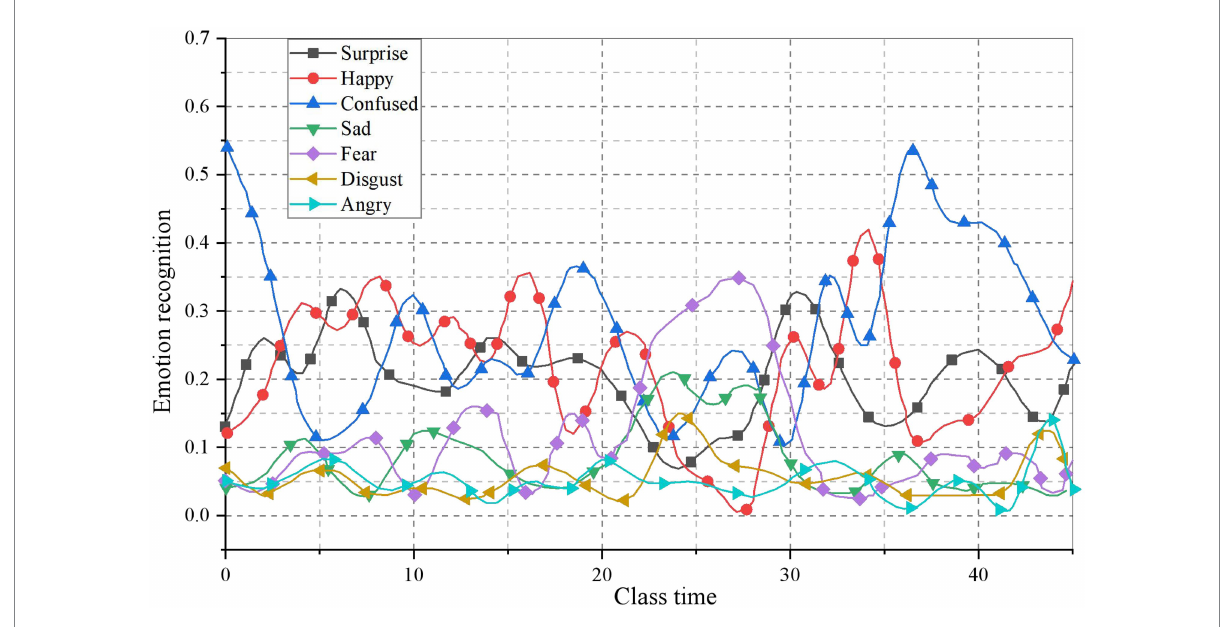
FIGURE 7 Results of students’ ER in the sixth week.